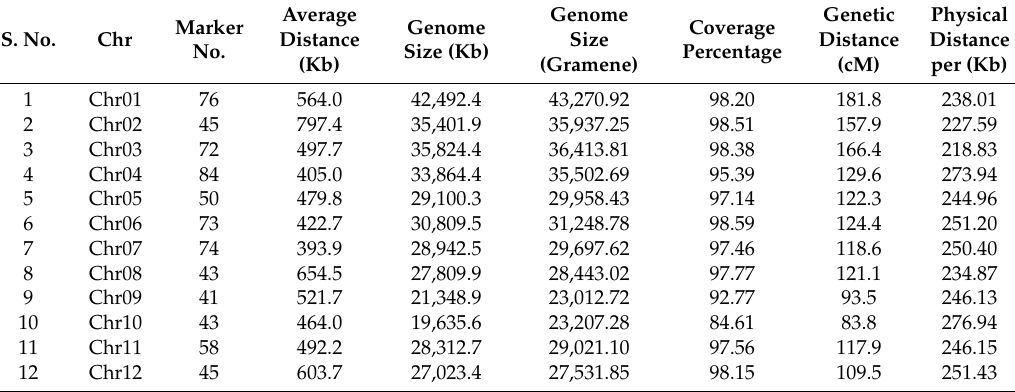
Table 5. Distribution of 704 polymorphic single nucleotide polymorphism (SNP) markers across the 12 chromosomes, with their average distance, genome size, coverage percentage, genetic distance, and physical distance per cM.